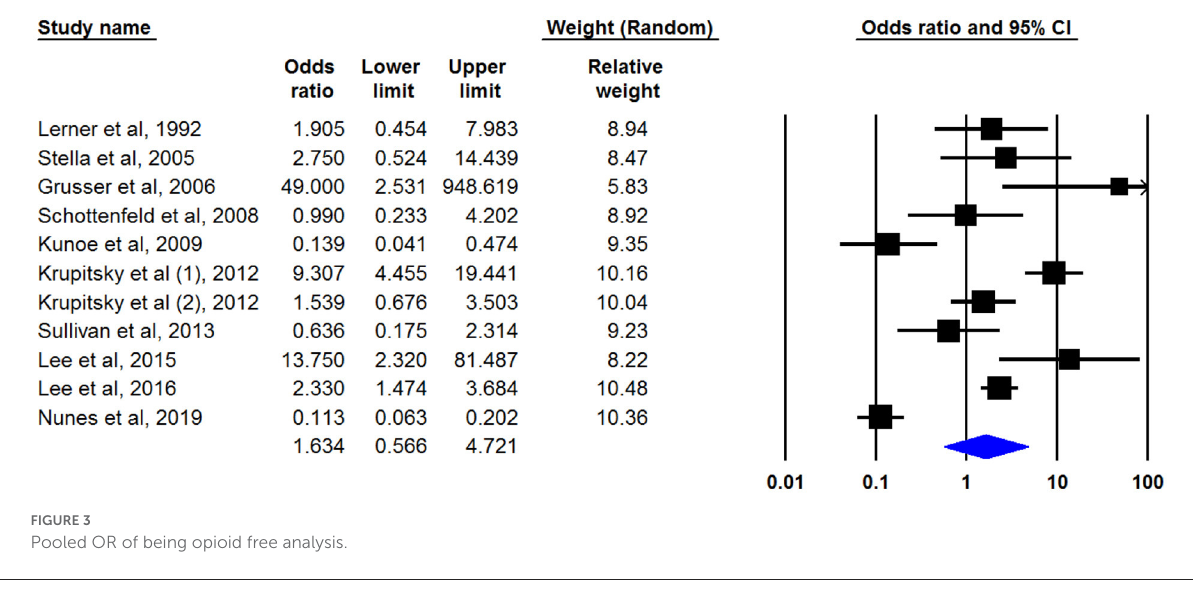
FIGURE3 Pooled OR of being opioid free analysis.